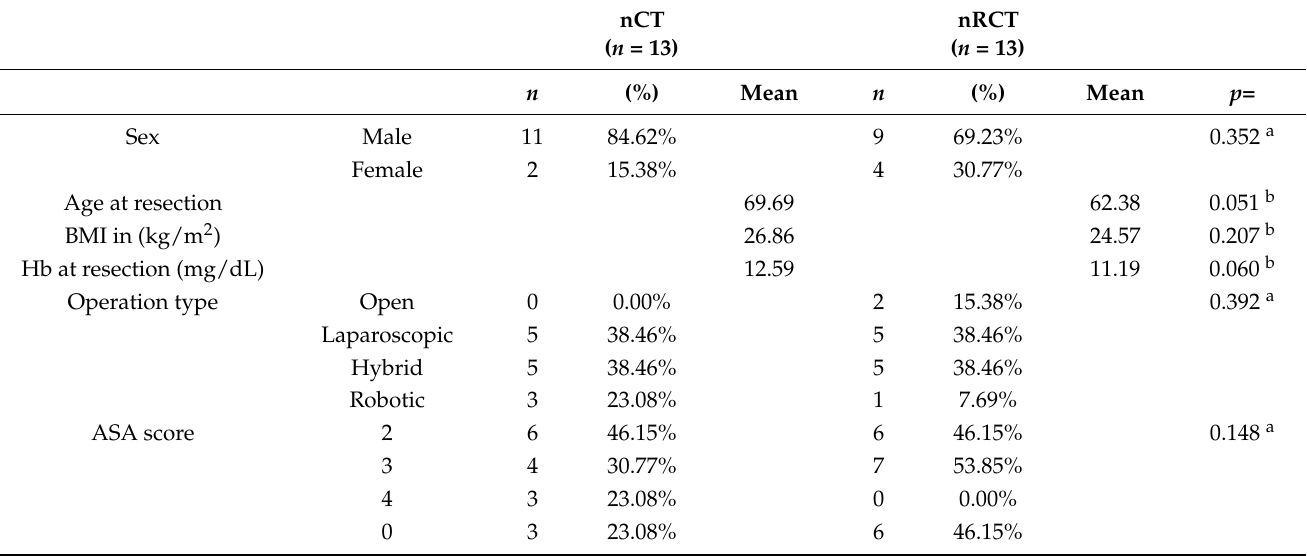
Table 1. Univariate analysis of patient characteristics and